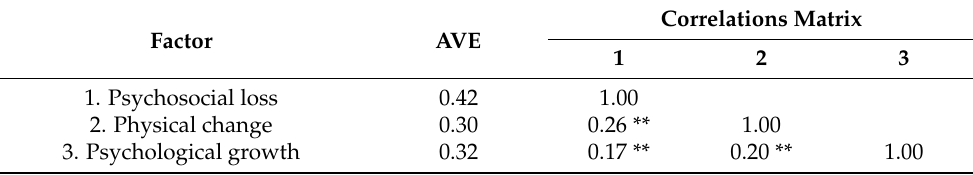
Figure 2. CFA of the re-specified 3-factorial AAQp. Table 4. Mean (M), standard deviation (SD), and squared factor